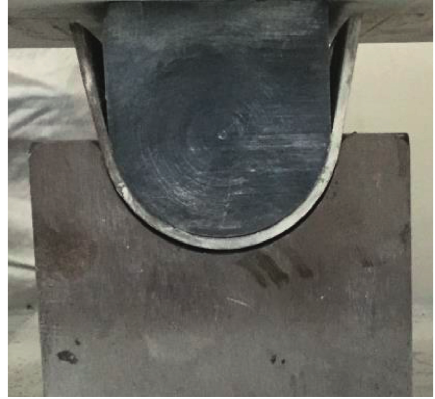
Figure 9: Experiment on cylindrical bending of TRB.